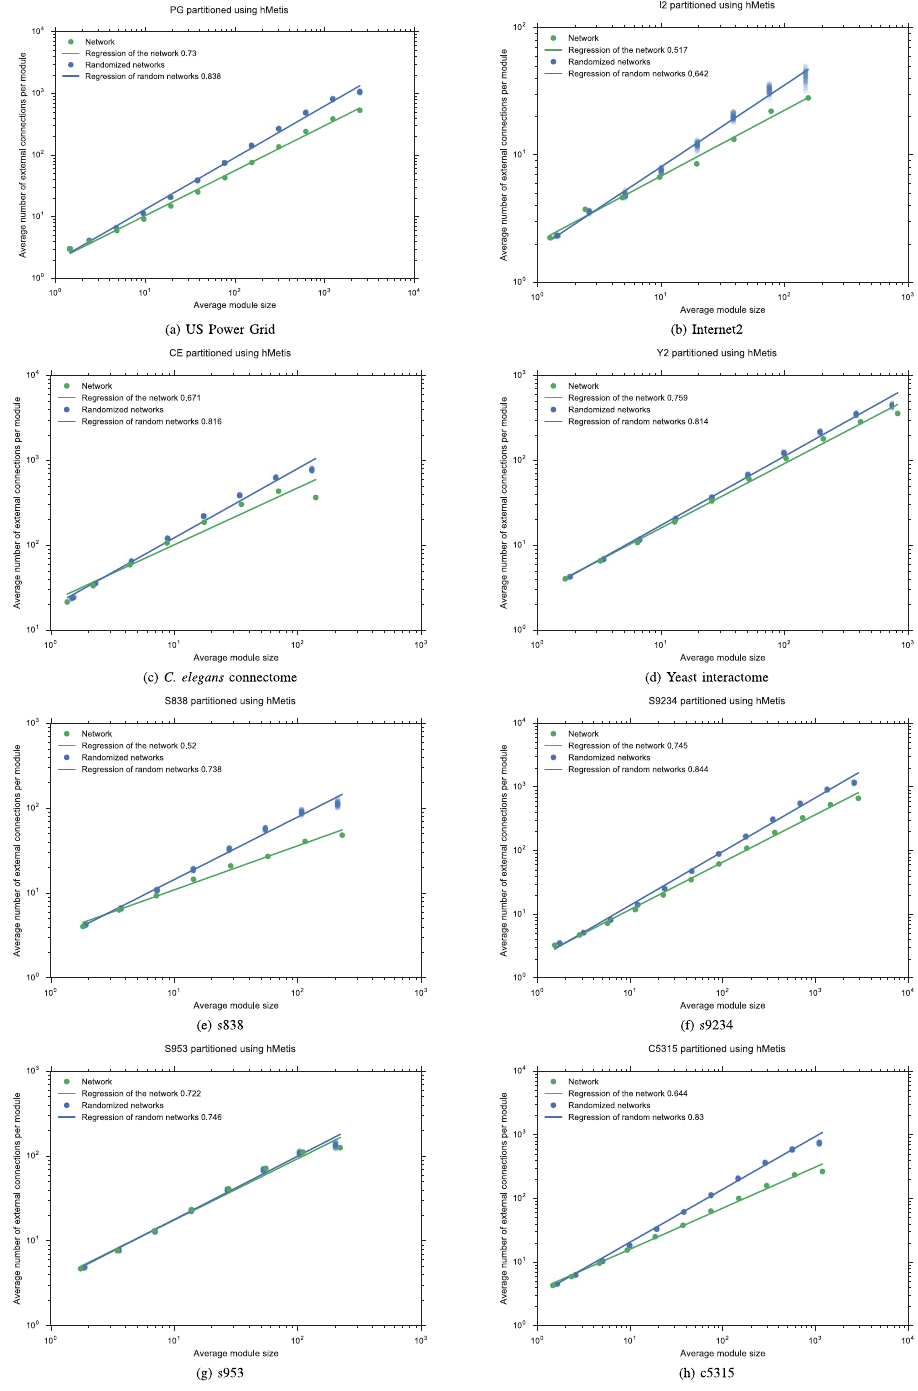
Figure 2. Recursive bipartitioning is applied to procure the Rent characteristic of each network, as well the whole Rent characteristic of a sample of 50 random network with the same degree distribution. Regressions and Rent exponents of both empirical and random networks are